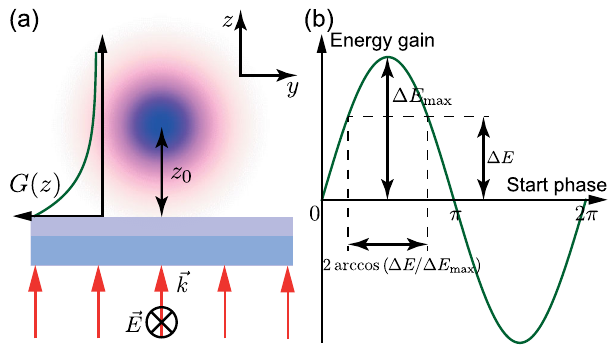
FIG. 9 (color online). (a) Side view of a dielectric grating (light blue) with an electron beam (dark blue) passing at a distance z 0 . The laser is incident from below (red arrows). We assume a constant laser field over the width of the Gaussian ≫ w electron beam profile ( w ) and model a 1D Gaussian l e current density [Eq. (7)] being subject to the acceleration gradient G ð z Þ ¼ 0 . 03 × eE exp ð − z= Γ Þ , with Γ ¼ 42 nm [Eq. (2)]. p (b) Energy gain as a function of start phase at a fixed distance from the grating surface [corresponding to a horizontal slice in Fig. 8(a)]. Here, we neglect deflection of the electrons. The differential accelerated fraction at this distance equals ζ ð Δ E; z Þ ¼ arccos ½ Δ E= Δ E ð z Þ(cid:2) = π max